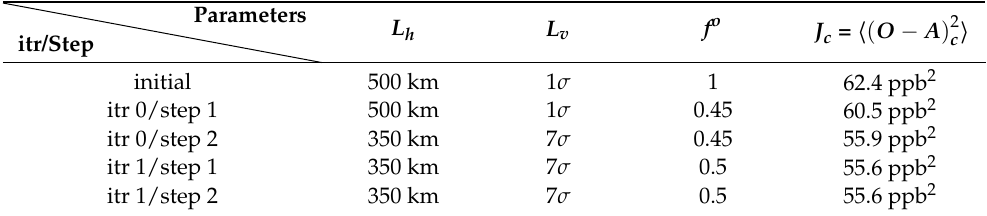
Table 1. Comparison of the error variance parameters ( L h , L v , and f o ) along with the cross-validation cost function generated with passive observations at different stages of iterative optimization, includ- ing the initial step, zero iteration (itr 0) and first iteration (itr 1). Each iteration contains two steps, one for optimizing f o (step 1) and another for optimizing L h and L v together. Parameters L h L itr/Step